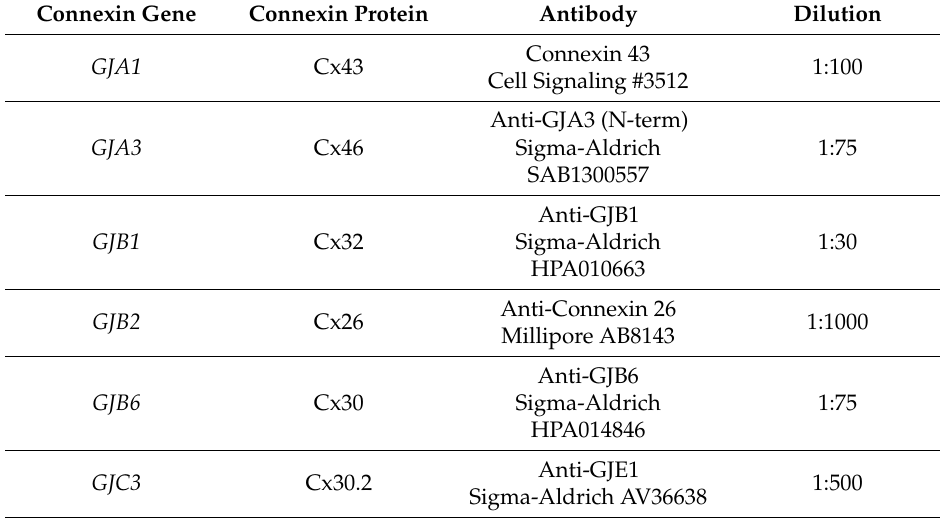
Connexin isotype specific polyclonal rabbit primary antibodies used for